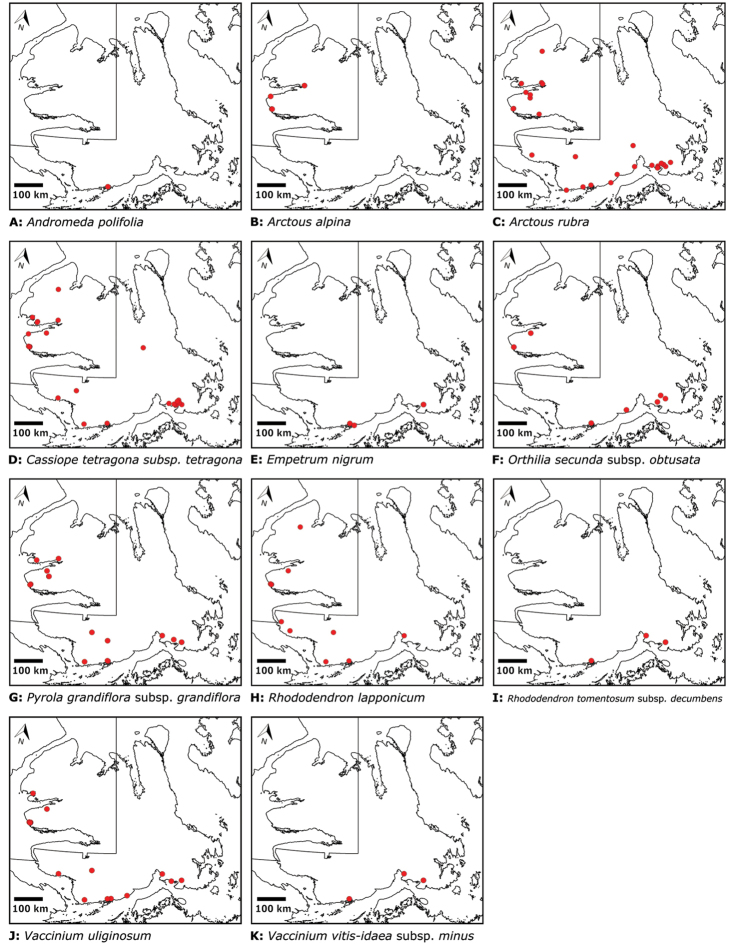
Species distribution maps. Ericaceae: AAndromeda
polifoliaBArctous
alpinaCArctous
rubraDCassiope
tetragona
subsp.
tetragonaEEmpetrum
nigrumFOrthilia
secunda
subsp.
obtusataGPyrola
grandifloraHRhododendron
lapponicumIRhododendron
tomentosum
subsp.
decumbensJVaccinium
uliginosumKVaccinium
vitis-idaea
subsp.
minus.